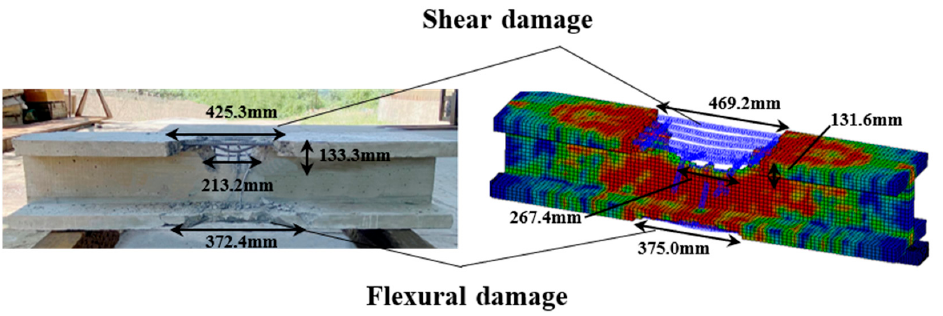
Figure 2. Damage behavior and numerical analysis results of the I-shaped RC beam under the blast load.